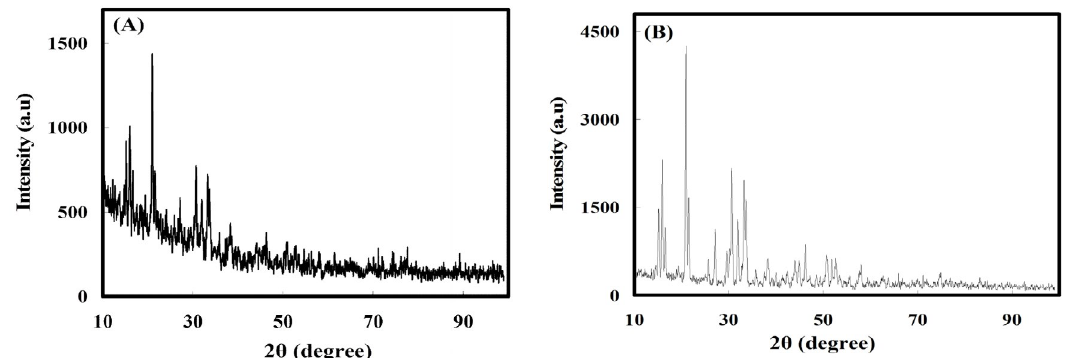
Fig. 5. XRD results of the Ag nanostructures prepared by (A) maceration and (B) MAE methods.